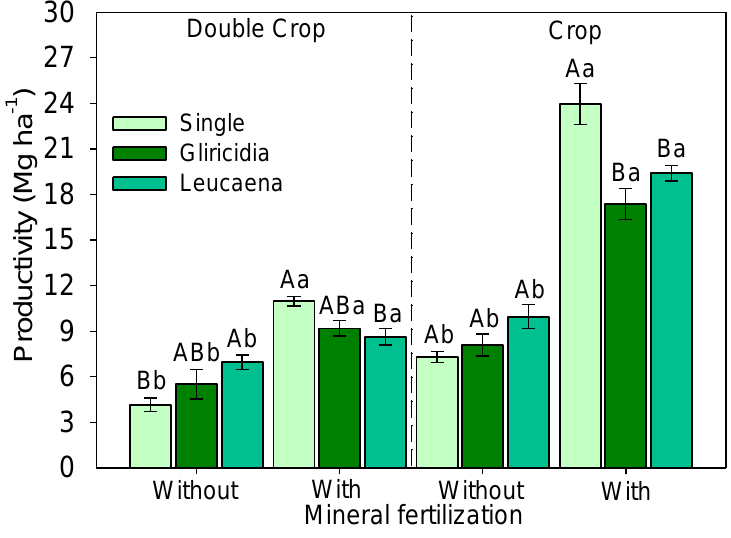
Figure 6. Productivity of forage sorghum cultivated with the combination of alleys and mineral fertilization. Averages followed by the same lowercase letter for fertilization and uppercase letter for cropping systems were found by the Tukey test to not differ from each other at 5%.